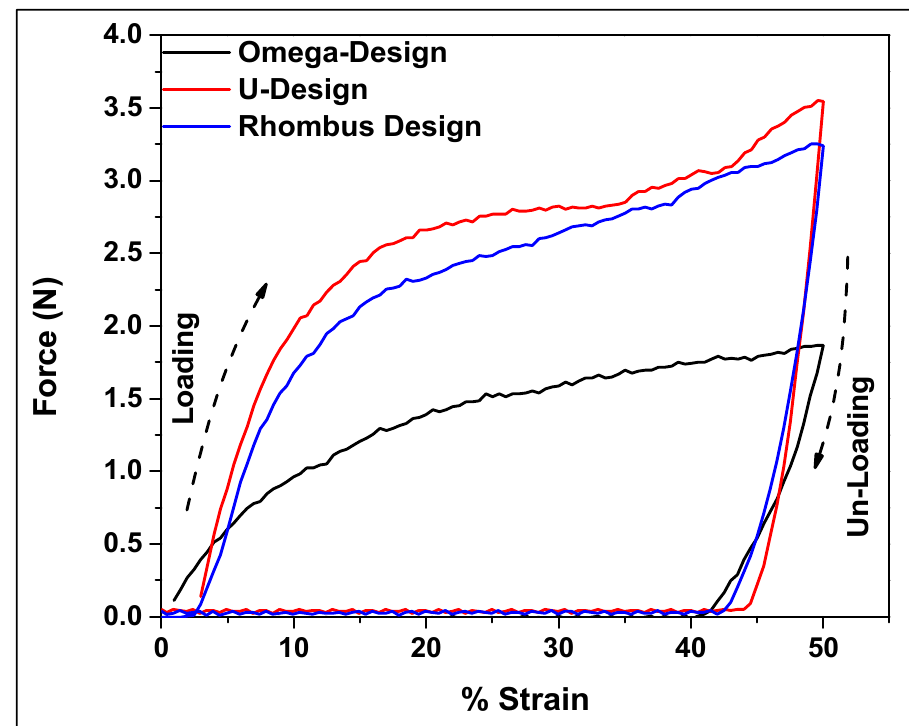
Figure 8. Mechanical behavior of Zn stent with rhombus, U and Omega design under compression after balloon expanding.